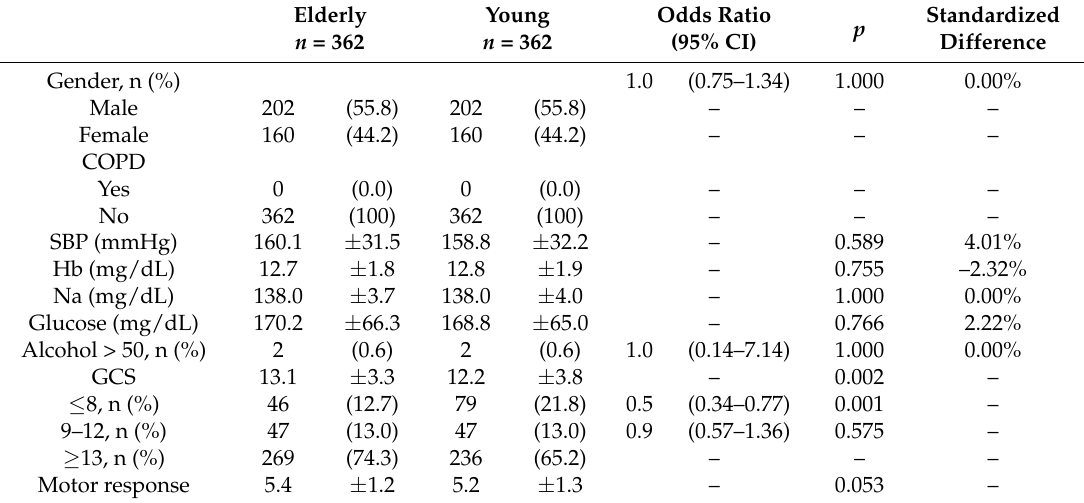
Table 5. Comparison of GCS score and motor response components in the selected propensity–score matched cohort of elderly and young adult patients with head AIS of 4.